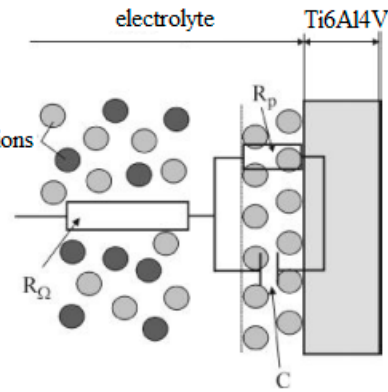
Figure 5. Interpretation of equivalent circuit for a simple corrosion system.